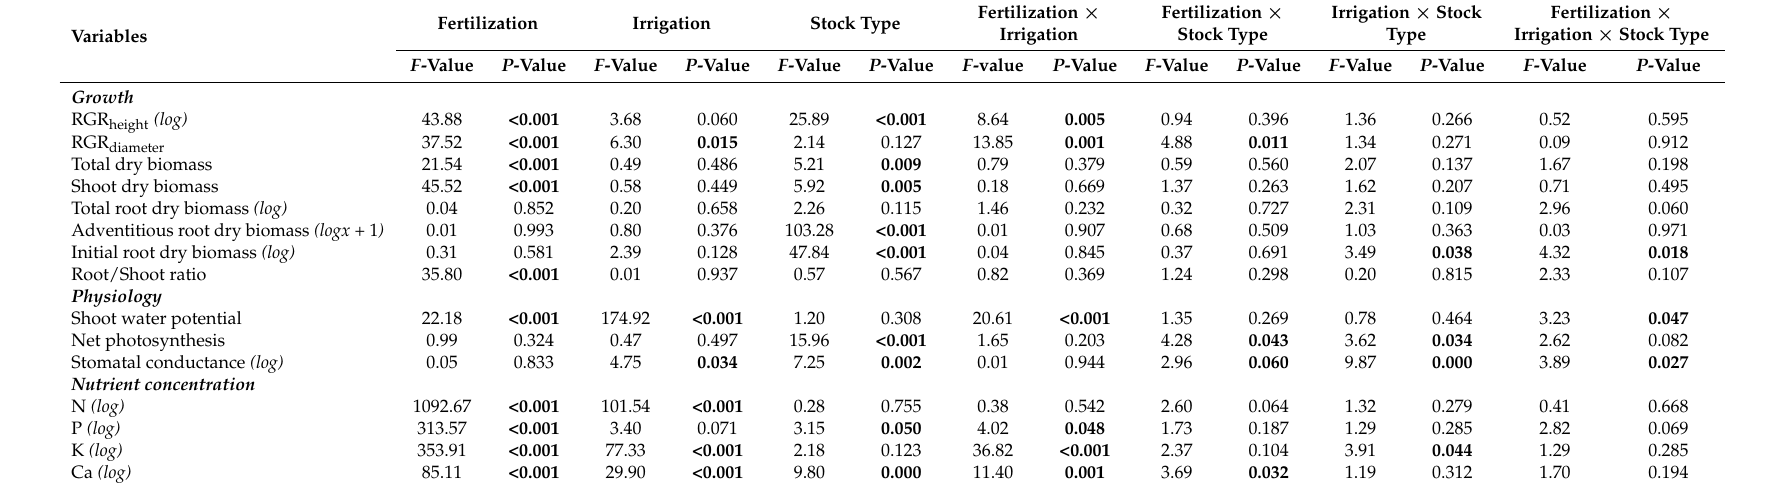
Table 1. Effects of fertilization, irrigation, and stock type on growth, physiology, and nutrient concentration of four-year-old black spruce seedlings. When required, analyses were performed on transformed data (indicated in parentheses). Statistically significant values at P ≤ 0.05 are in